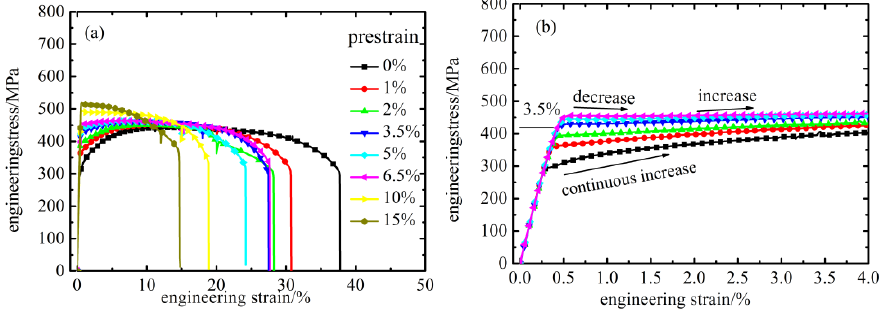
Figure 3. Engineering stress–strain curves of different prestrained specimens. ( a ) 0%–15% prestrained CP-Ti and ( b ) the appearance of yield plateau.